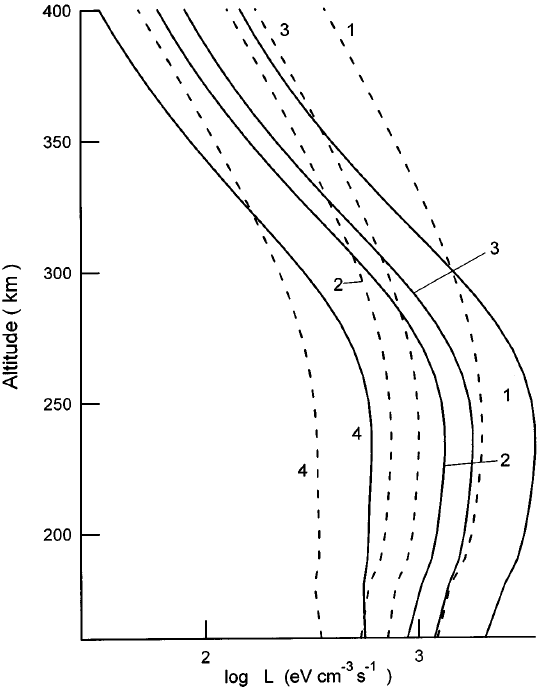
Fig. 4. Comparison of cooling rates due to fine structure excitation of atomic oxygen at 12.00 LT on 7 April, 1990 ( solid lines ) and 9 April, 1990 ( dashed lines ) given by Dalgarno (1969) ( curves 1 ) and calculated by the use of the e(cid:128)ective collision strengths of Tambe and Henry (1974, 1976) ( curves 2 ) and Le Dourneuf and Nesbet (1976) ( curves 3 ) with the oxygen fine structure cooling rate found here, ( curves 4 ) which is based on the e(cid:128)ective collision strengths of Bell et